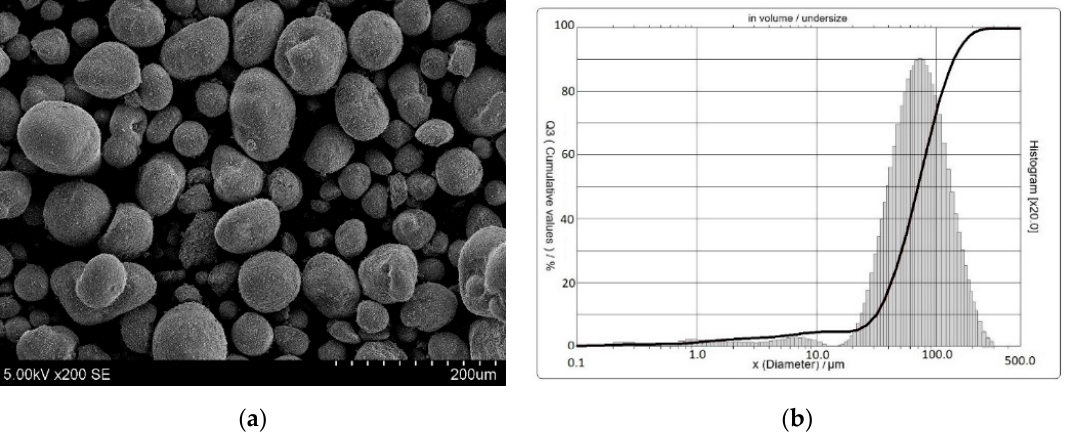
Figure 7. The SEM analysis ( a ) and granulometric composition ( b ) of zeolitic waste. As shown in the oxide composition (Table 1), in the biomass bottom ash, the CaO (44.0%)